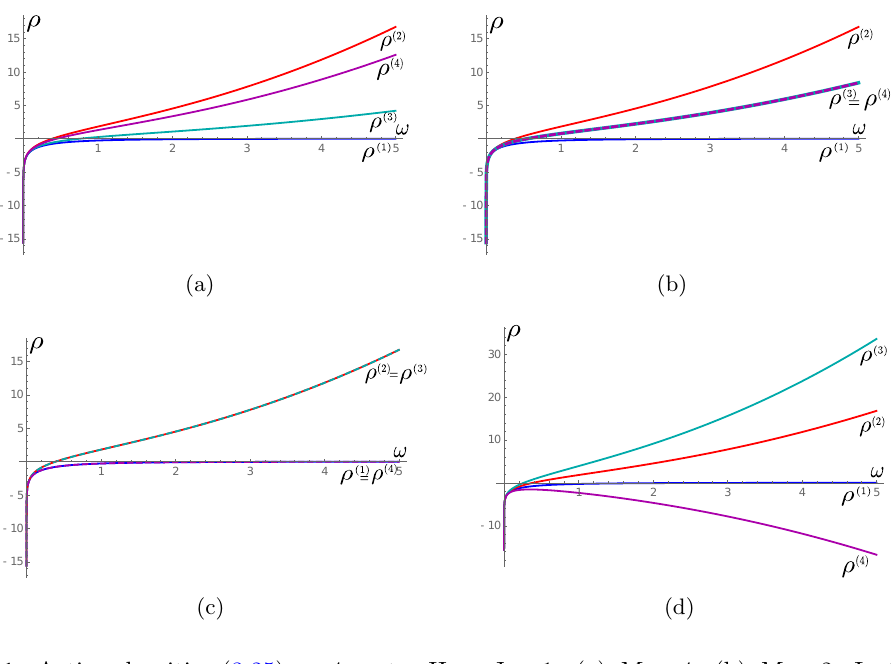
Figure 1 . Action densities (3.25) on 4 roots. Here J = 1. (a) M = 4. (b) M = 2. In this case (cid:26) (3) = (cid:26) (4) . (c) M = 1. In this case (cid:26) (1) = (cid:26) (4) and (cid:26) (2) = (cid:26) (3) . (d) M = 0 :